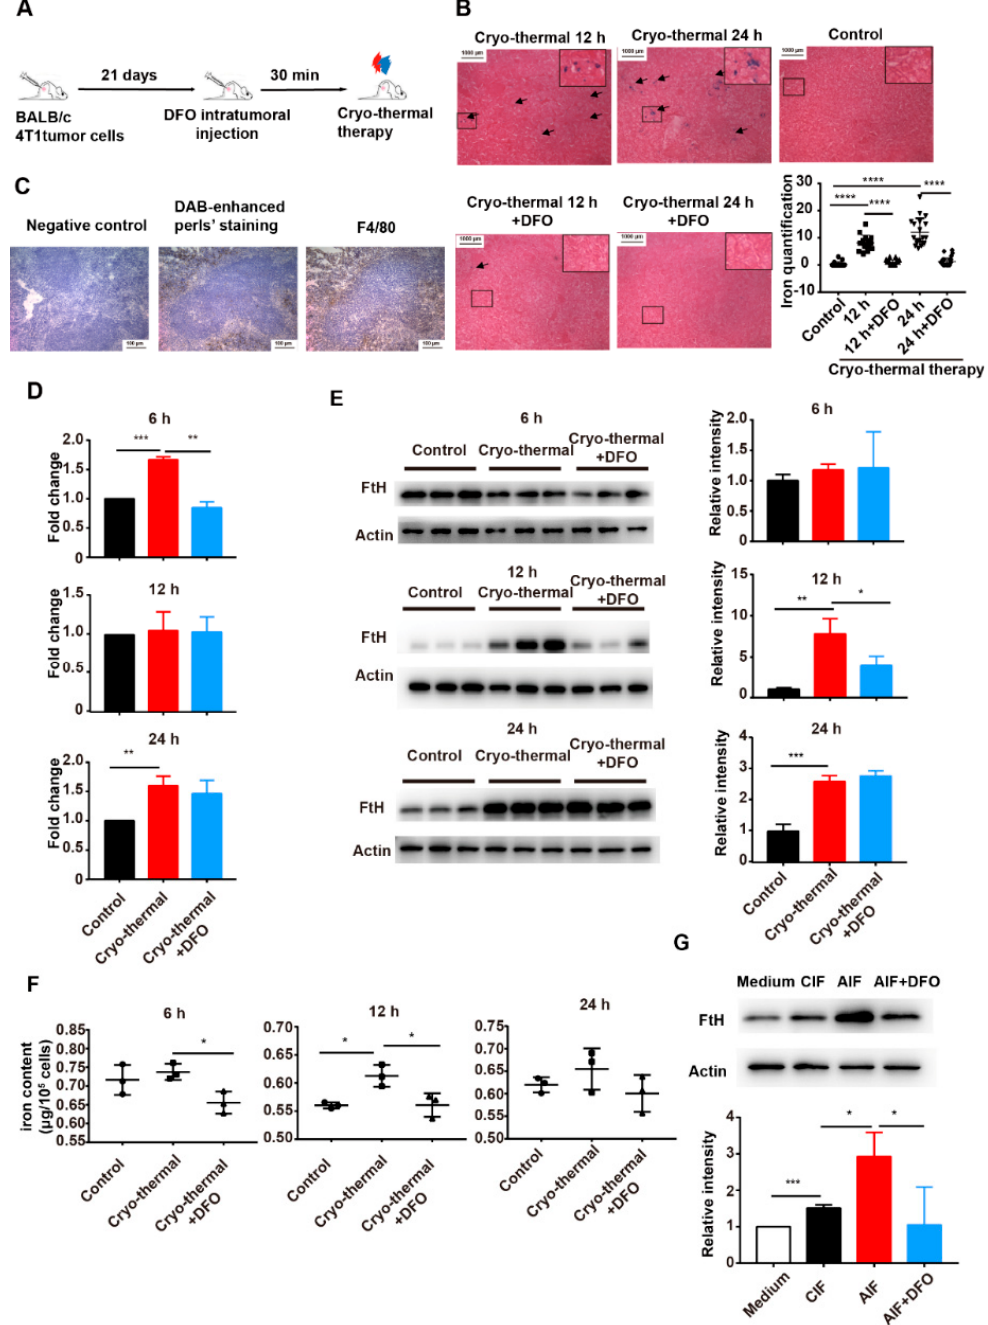
Figure 2. Splenic macrophages taken up the iron after cryo-thermal therapy. ( A ) Schematic of experimental design. 4T1 tumor-bearing mice were injected with DFO introtumoral 30 min before cryo-thermal therapy and spleens were harvested for analyzing the changes in iron. ( B ) Representative Perls’ staining of the spleen after cryo-thermal therapy with or without DFO injection. ( C ) Representative DAB-enhanced Perls’ staining (middle) and immunohistochemistry staining using an F4/80 antibody (right). ( D , E ) Splenic macrophages were sorted and the mRNA levels and protein levels (fold change) of FtH were determined by RT-qPCR and western blot, respectively. ( F ) F4/80 + macrophages were sorted by flow cytometer and iron contents were quantified by ICP-MS. ( G ) RAW264.7 cells were treated with tumor interstitial fluid from control or cryo-thermal treated mice. DFO was added to chelate iron in the medium. After 24 h of cultivation, protein levels of FtH were determined by western blot. * p < 0.05, ** p < 0.01, *** p < 0.001, **** p < 0.0001, n = 3 for each group. 2.3. The Iron Released from the Primary Tumor Promoted M1 Polarization after Cryo-Thermal Therapy In order to investigate the impact of iron on M1 polarization of macrophages after cryo-thermal therapy, mice were treated by cryo-thermal therapy alone or cryo-thermal therapy combined with intratumoral injection of DFO. The frequency of M1macrophages (CD86 + MHC Ⅱ + ) was detected by flow cytometry (Figure S1). As in our previous results, the percentage of M1 macrophages in the spleen was reduced at 12 h but increased at 24 h and 72 h after cryo-thermal therapy (Figure 3A). However, the M1 macrophage polari- zation induced by cryo-thermal therapy was abrogated at 24 h with DFO treatment (Fig-